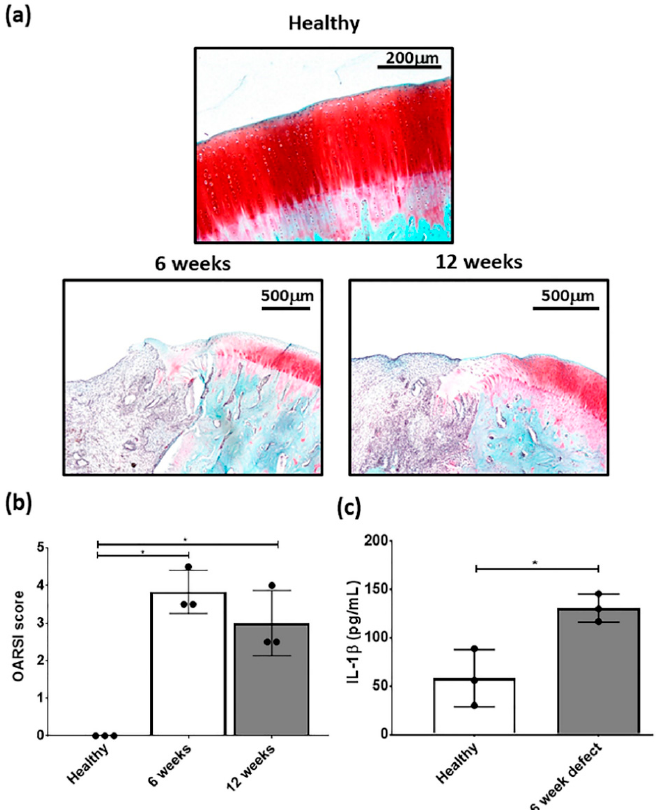
Figure 3. Representative ( a ) safranin-O/fast green stained healthy, 6 and 12 week defects used for the examination of focal early OA in the defect. ( b ) OARSI score for healthy, 6 and 12 week defects post-surgery and ( c ) measurement of IL-1 β in cartilage from healthy and defect cartilage. Data represent mean ± S.D.; n = 3, with dots representing the mean from three blinded scorers (five sections per defect). * p < 0.05.